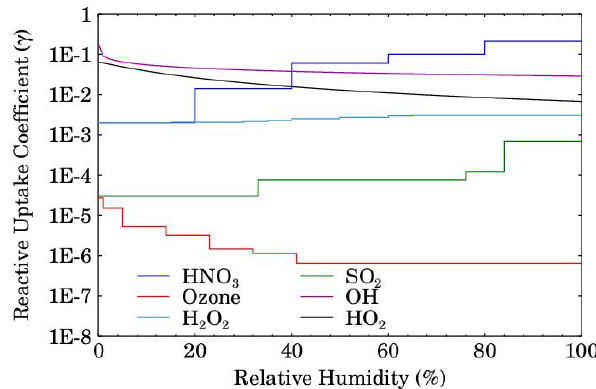
Figure 1. The relative humidity dependence of reactive uptake co- efficient ( γ) for O 3 , HNO 3 , OH, HO 2 , H 2 O 2 and SO 2 used in this